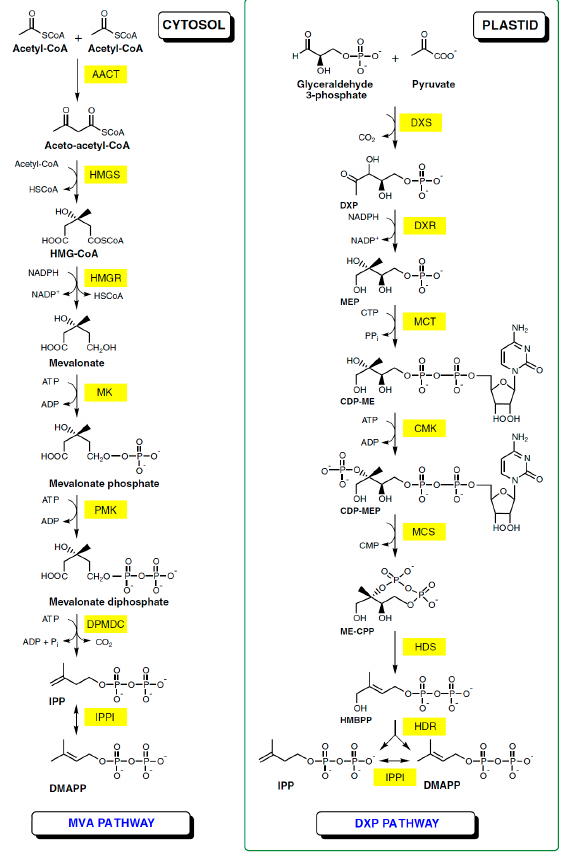
Figure 2. IPP formation by the MPA and DXP pathways [12].